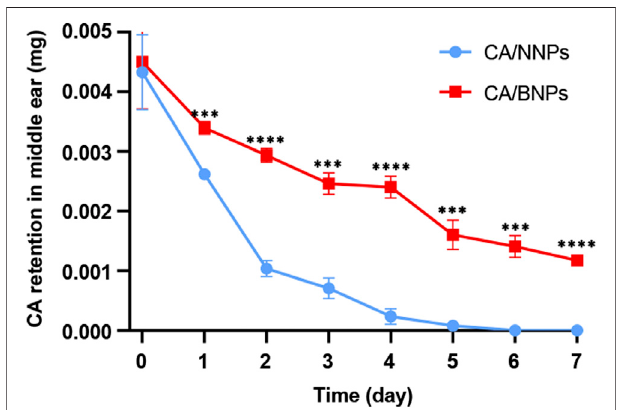
FIGURE 4 | Quanti fi cation of CA retained in the middle ear for 7 days. Data are means ± SD ( n = 3). *** p < 0.001, **** p < 0.001, compared with the CA/NNP-treated group (Student ’ s